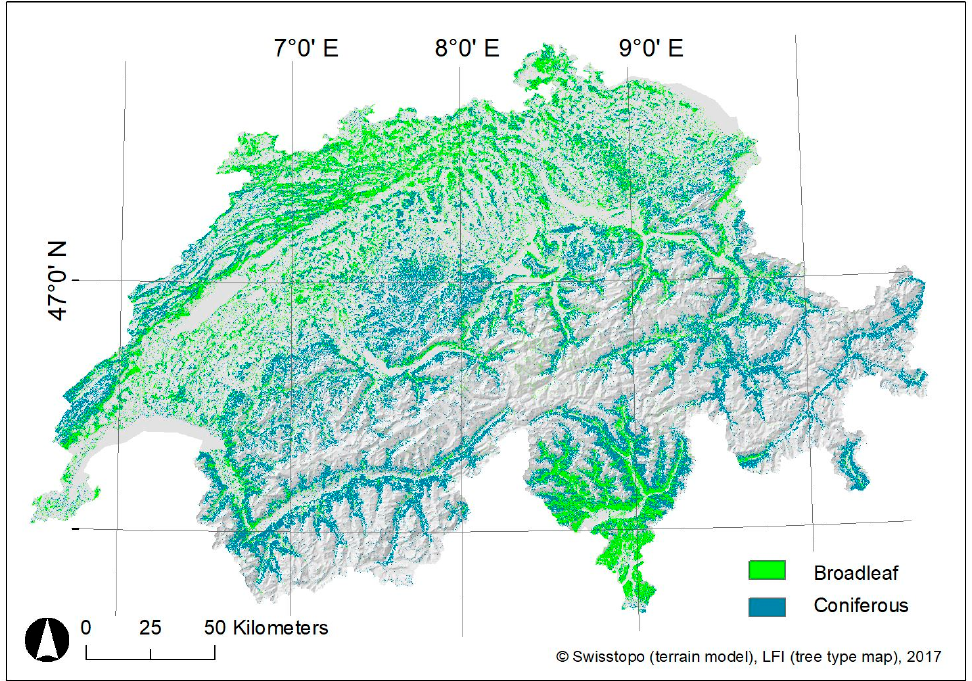
Figure 5. Tree type map of Switzerland with the distinction between broadleaved and coniferous trees.